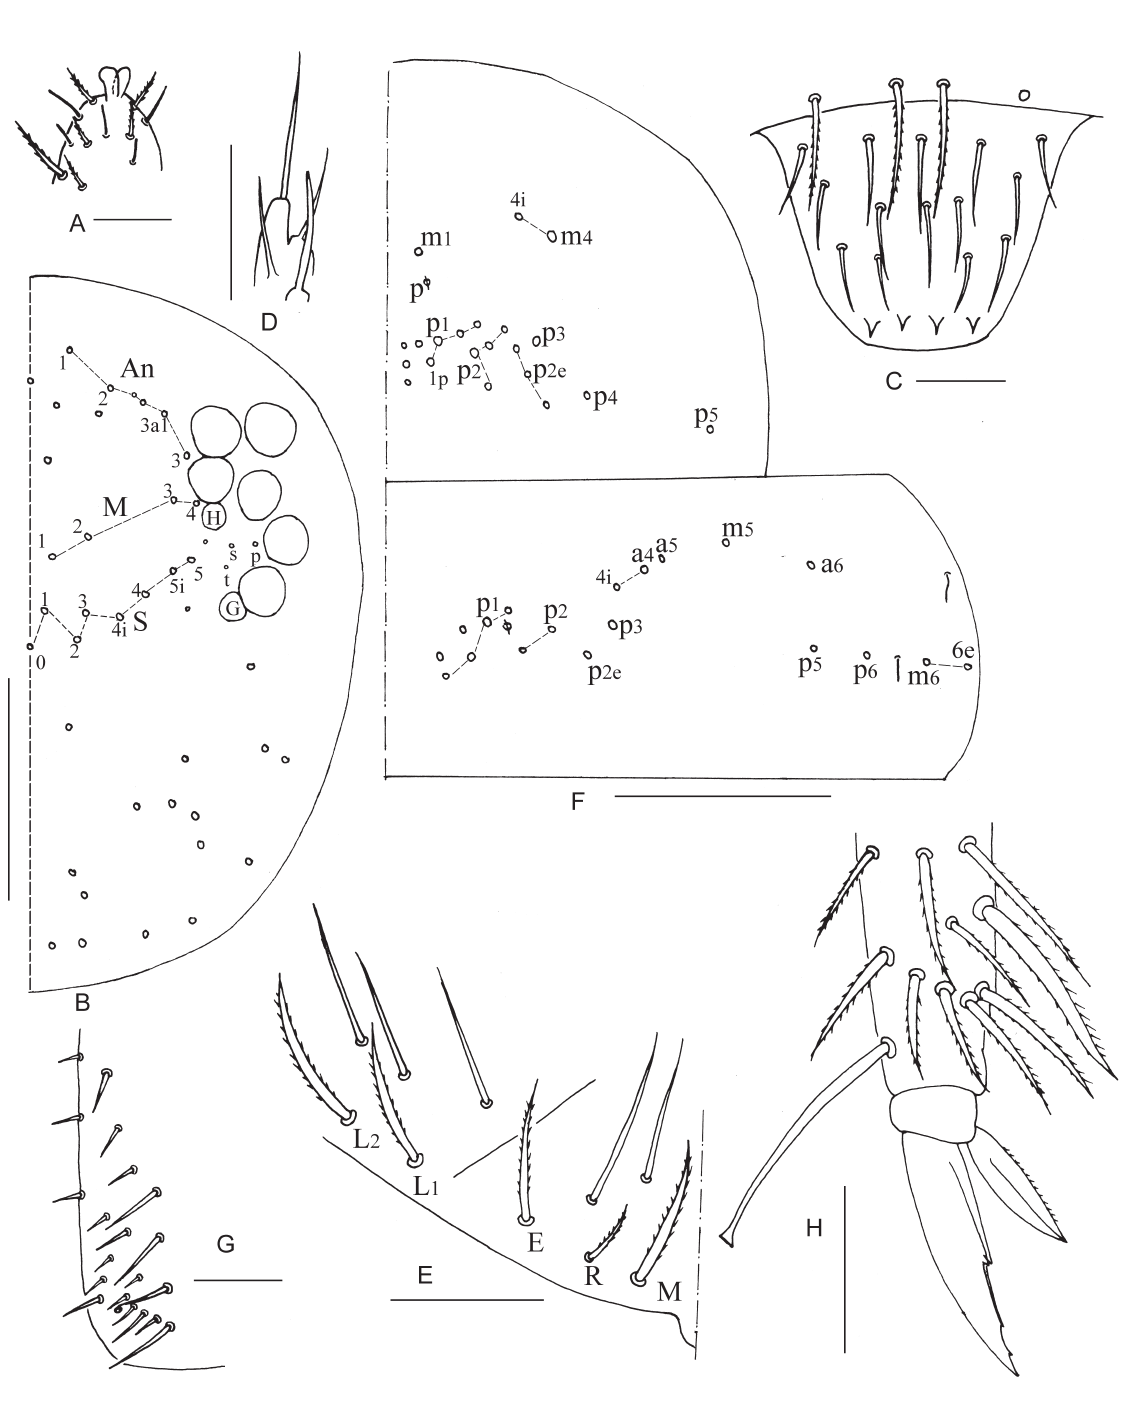
Fig. 6. Willowsia christianseni sp. nov. A . Apex of Ant. IV. B . Dorsal chaetotaxy of head. C . Labrum. D . Lateral process of labial palp. E . Labium. F . Chaetotaxy of Th. II−III. G . Trochanteral organ. H . Foot complex. Scale bars: A, C−E, G–H = 20 μm; B, F = 100